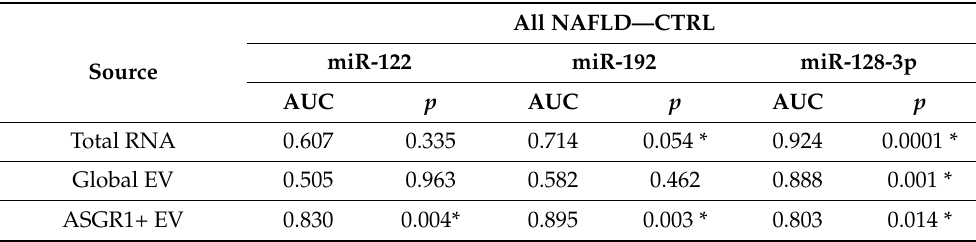
Table 4. Area under the receiver operator characteristic curve for miRNA biomarkers isolated from total cell-free RNA, global EVs, and ASGR1+ EVs. All NAFLD—CTRL miR-122 miR-192 miR-128-3p Source AUC p AUC p AUC p Total RNA 0.607 0.335 0.714 0.054 * 0.924 0.0001 * Global EV 0.505 0.963 0.582 0.462 0.888 0.001 * ASGR1+ EV 0.830 0.004* 0.895 0.003 * 0.803 0.014